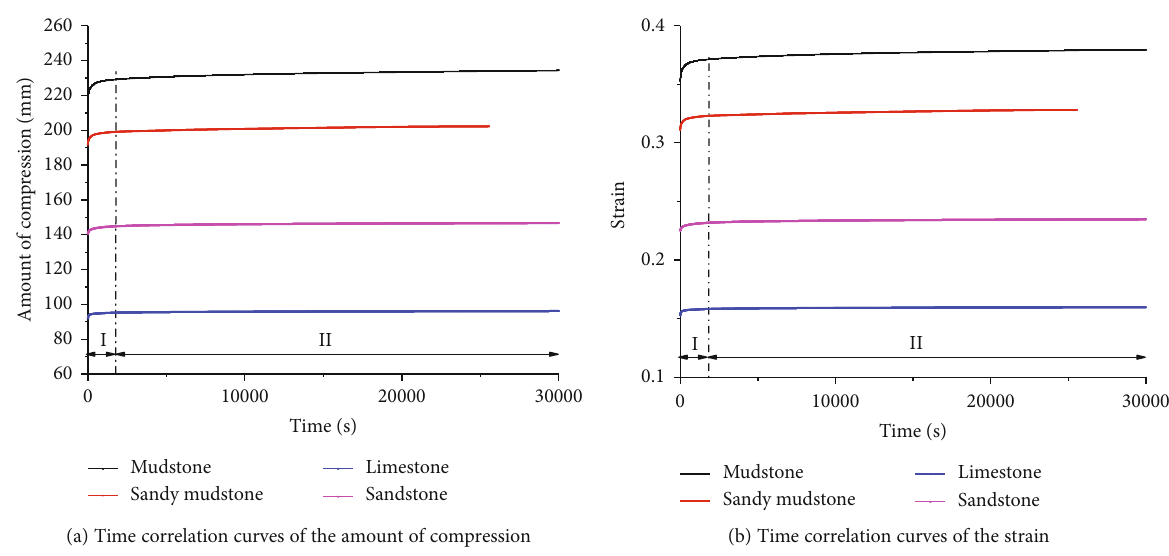
Figure 3: Time correlation curves of the amount of compression and strain for caving crushed rock samples of di ff erent lithology (axial stress of 3.5 MPa).